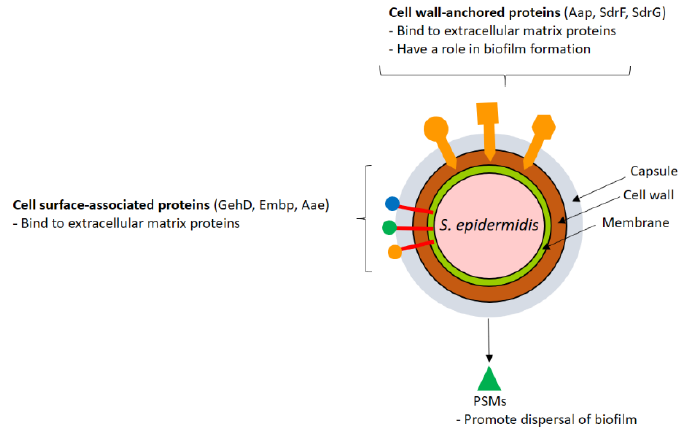
Figure 2. Schematic representation of Staphylococcus epidermidis virulence factors. S. epidermidis has